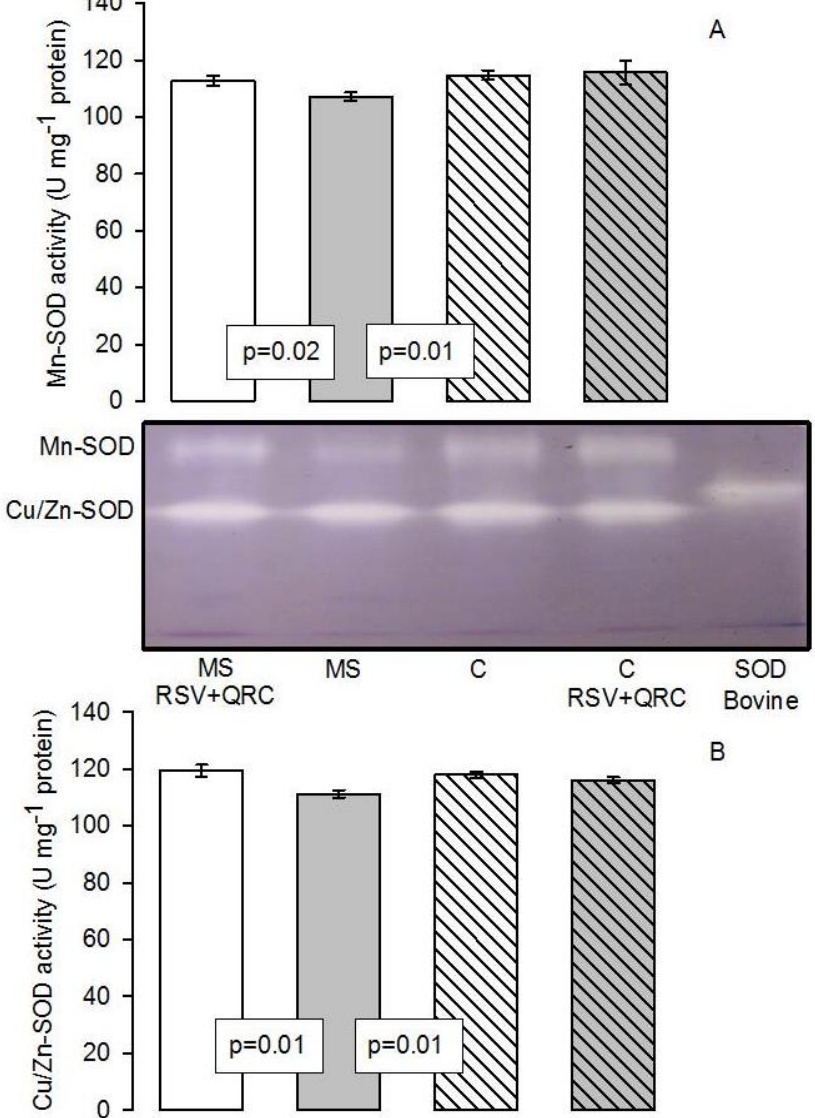
Figure 3. Histogram representing the densitophotometric analysis of the activity of superoxide dismutase (SOD) isoforms in the liver homogenates of the experimental rats. A representative native gel of the activities of the Mn-SOD and Cu/Zn-SOD electrophoresis between the graphic A and B is shown. ( A ) Manganese isoform, and ( B ) Copper/zinc isoform. Abbreviations: MS = metabolic syndrome, C = control, RSV = resveratrol, QRC = quercetin. Data are expressed in means ± SE, ( n = 8, rats in each group).